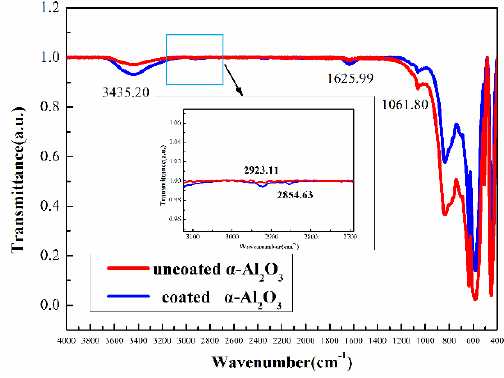
Figure 7. Fourier transform infrared (FTIR) spectrum of coated and uncoated α-Al 2 O 3